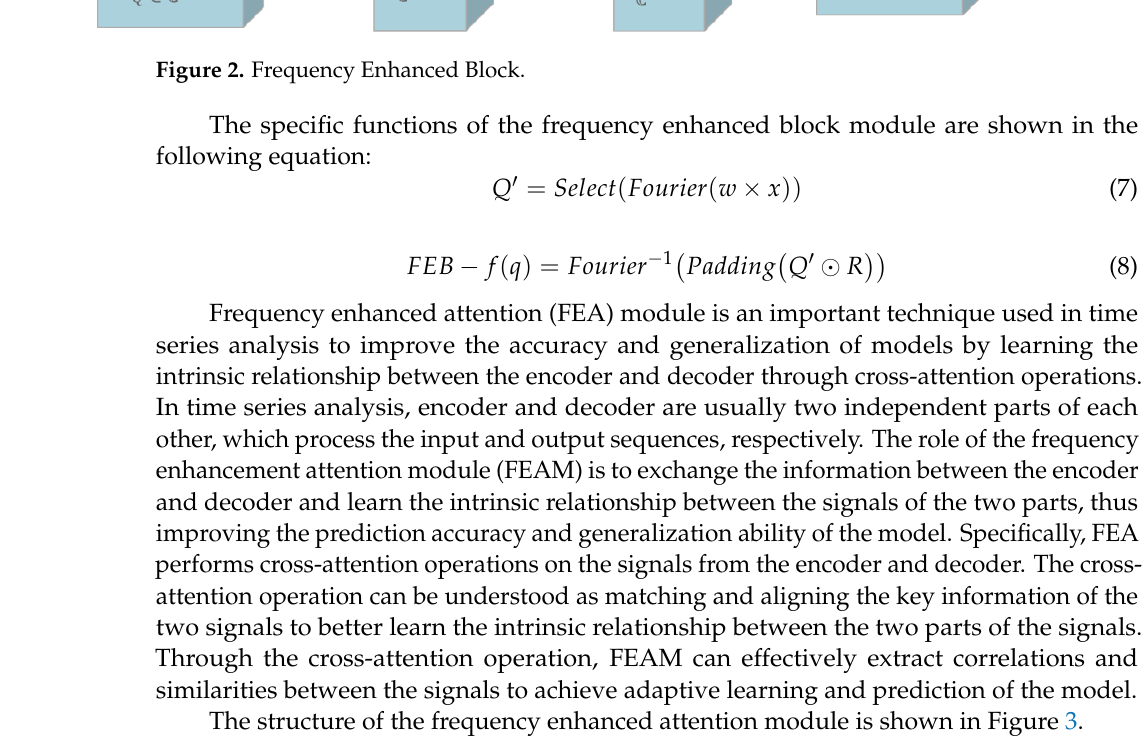
Figure 2. Frequency Enhanced Block.